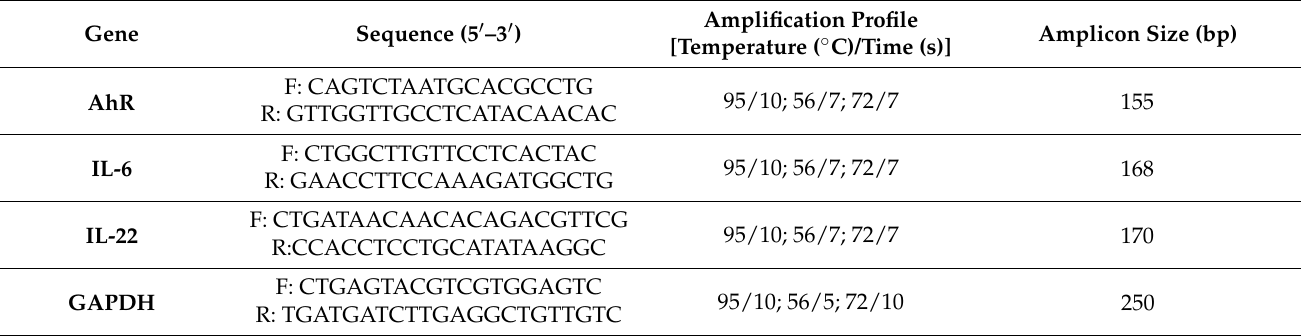
Table 1. Target genes, primers sequences, amplification profile, and amplicon size during Real Time PCR reaction AhR, Aryl-hydrocarbon Receptor; GADPH, glycerin-aldehyd-3-phosphat- dehydrogenase; IL,